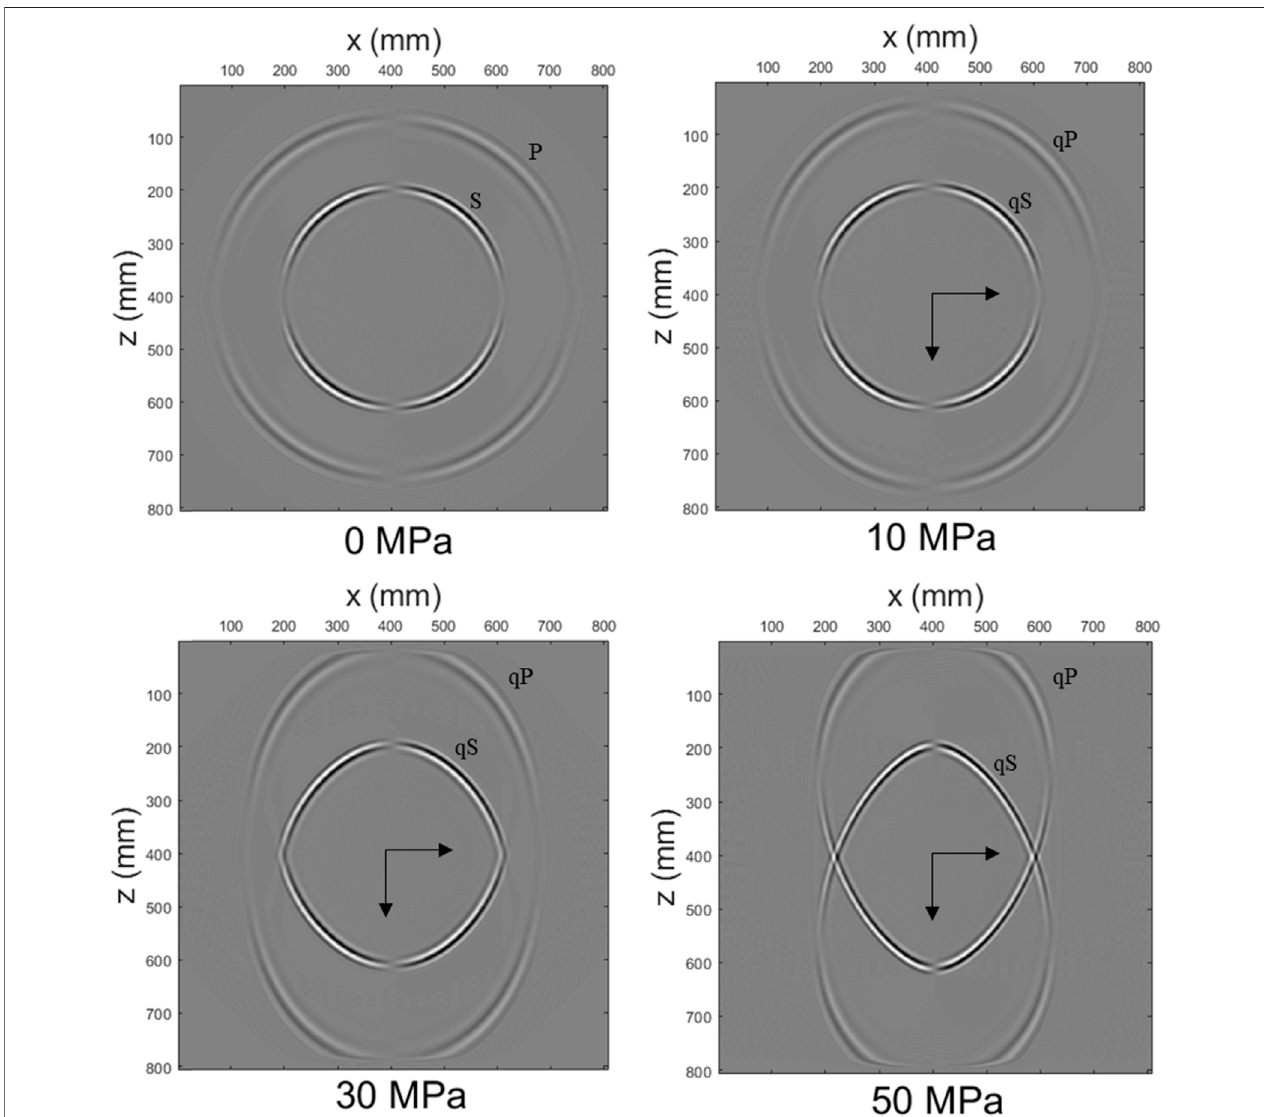
FIGURE 9 | Wave fi eld snapshots of the x -component of the particle velocity at t = 0.12 ms for various pure-shear stresses. The arrow indicates the principalstrain direction calculated by Eq. 47 .